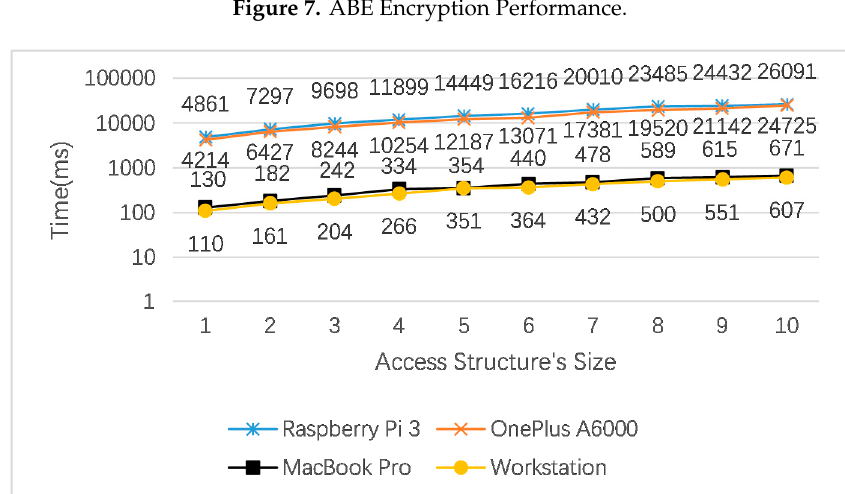
Figure 7. ABE Encryption Performance. Appl. Sci. 2019 , 9 , x